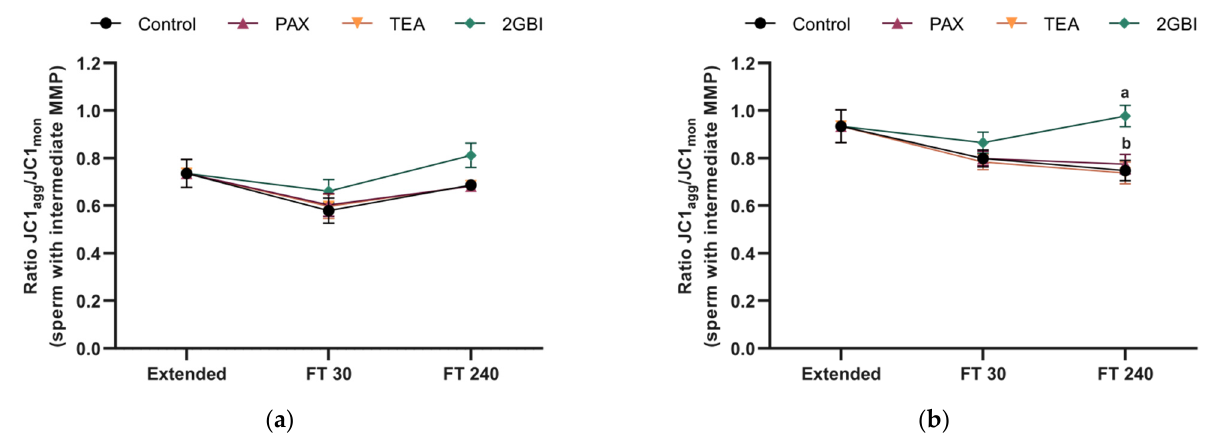
Figure 7. JC1 agg /JC1 mon ratios in extended and frozen–thawed (FT) samples at 30 min and 240 min post-thaw. In Experiment